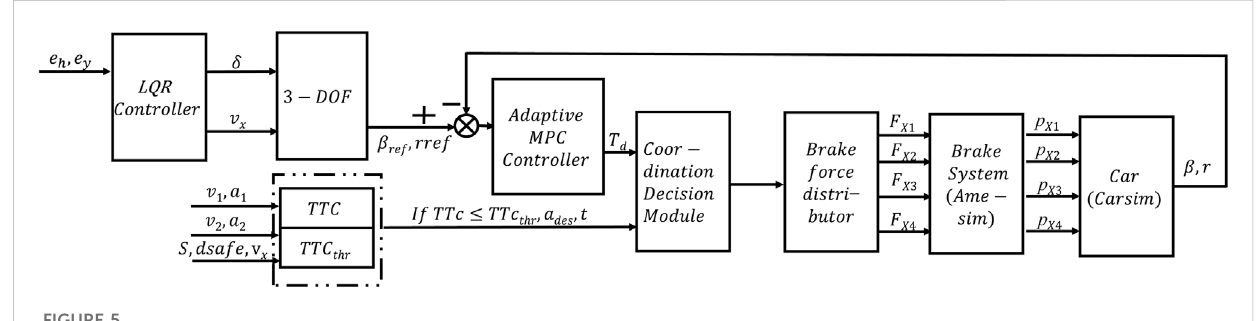
FIGURE 5 Vehicle emergency steering and collision avoidance stability control.